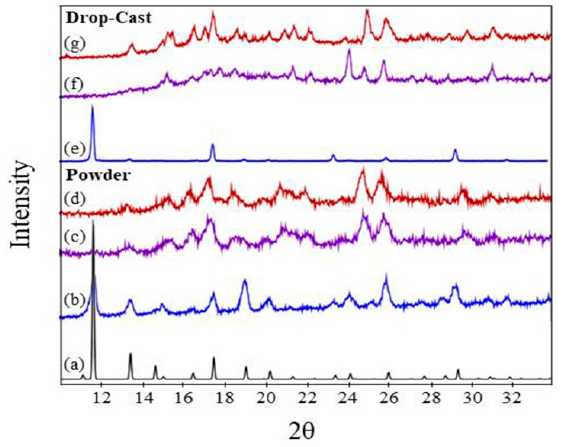
Figure 4. XRD patterns of ( a ) reference for HKUST-1 powder (ICDD pdf number 00-062-1183); ( b ) powder before exposure to NH 3 ; ( c ) powder after exposure without activation; ( d ) powder after exposure with prior activation; ( e ) drop-cast thin film before exposure to NH 3 ; ( f ) drop-cast thin film after exposure without activation; and ( g ) drop-cast thin film after exposure with prior activation.